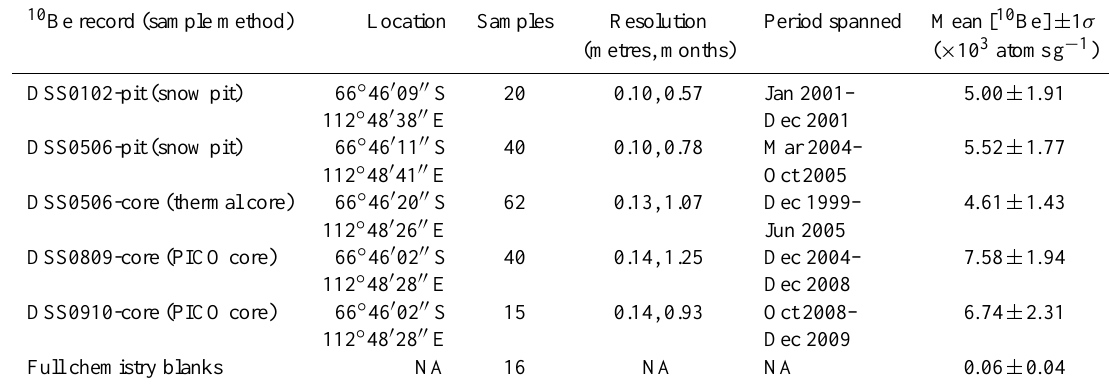
Table 1. Details of the high-resolution DSS, Law Dome 10 Be snow pit and ice core records discussed in the text. 10 Be record (sample